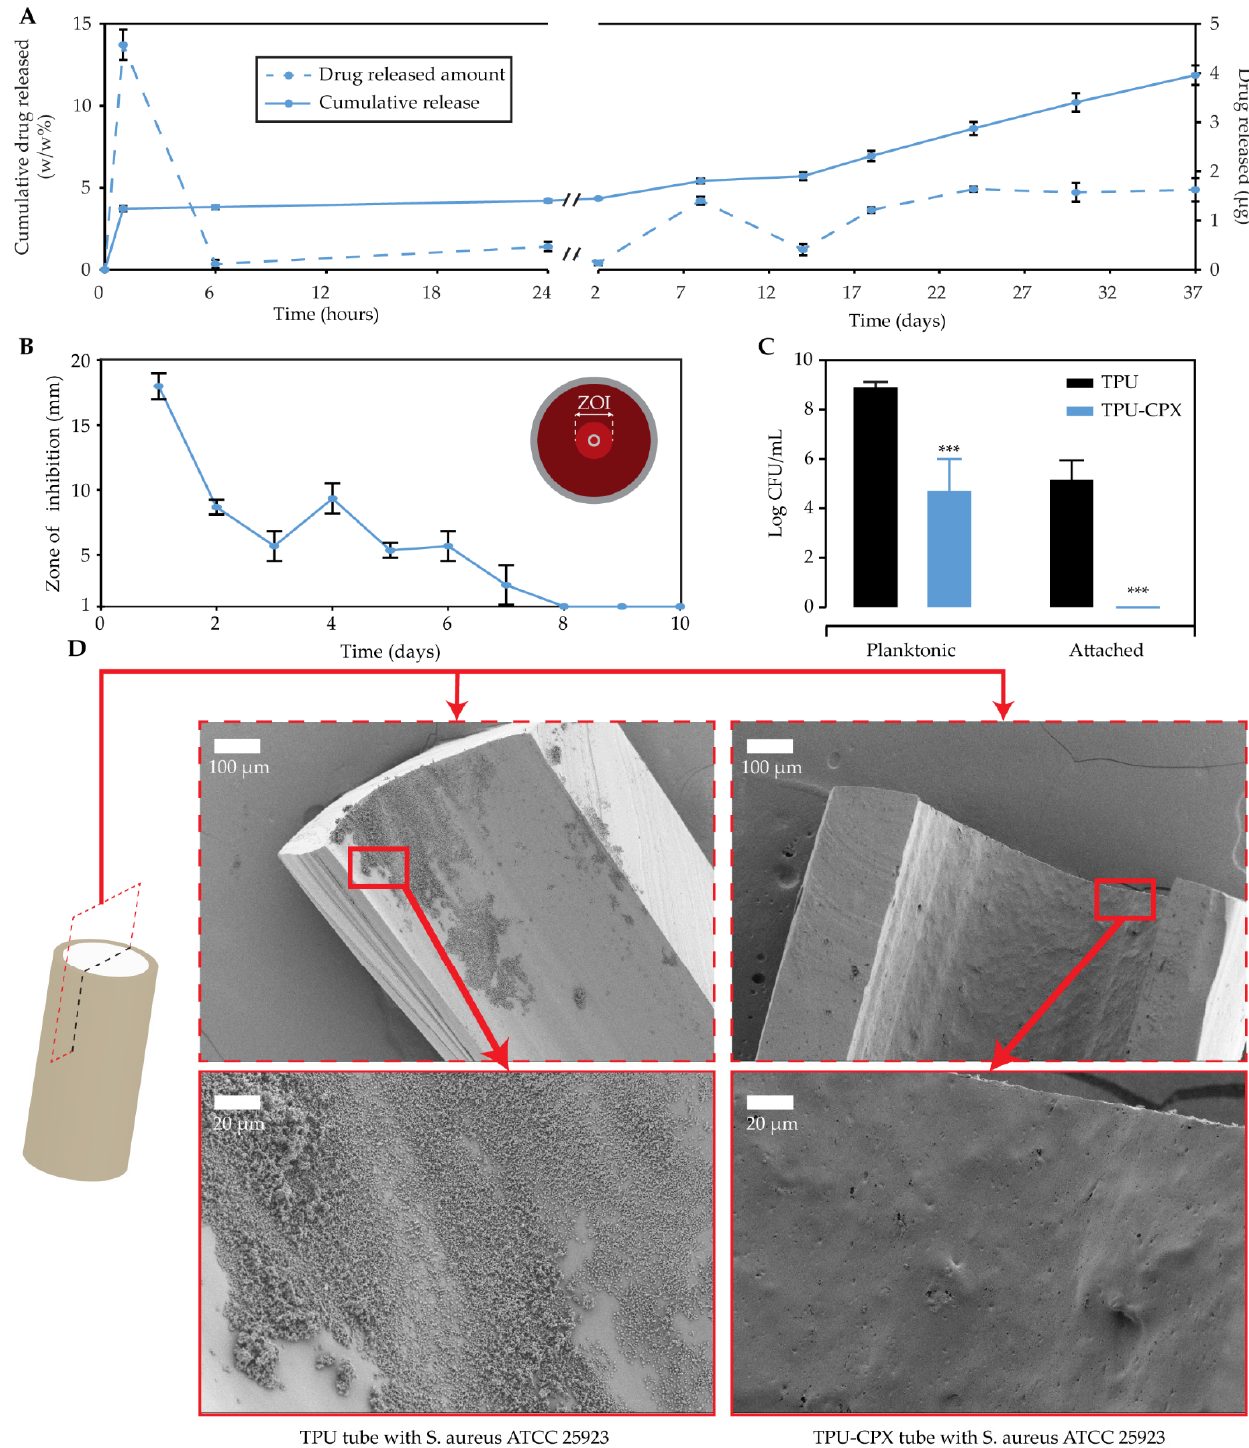
Figure 5. Released drug profile for TPU-CPX tubes: single timepoints (dashed) and cumulative (continuous) ( A ), bacterial zone of inhibition assay ( B ), bacterial adhesion assay: TPU (black) and TPU-CPX (blue) ( C ), and SEM visualization of bacterial attachment for cross-sections of non-loaded and drug-loaded TPU tubes with 100× and 500× magnification and 3 kV surface tension ( D ). Note: n = 3 in ( A , B , D ) and n = 6 in ( C ). An unpaired t -test was performed in C and *** indicates p < 0.001.